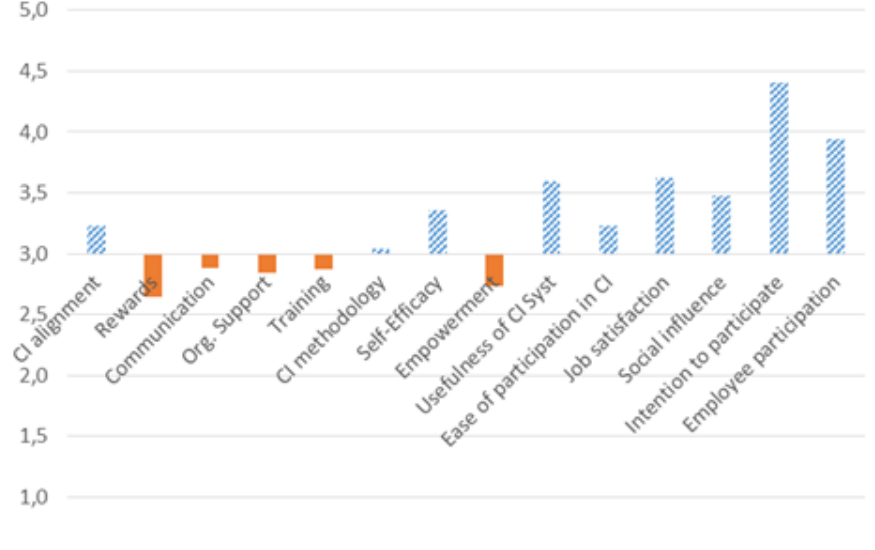
Figure 4. Service case: general mean perceptions